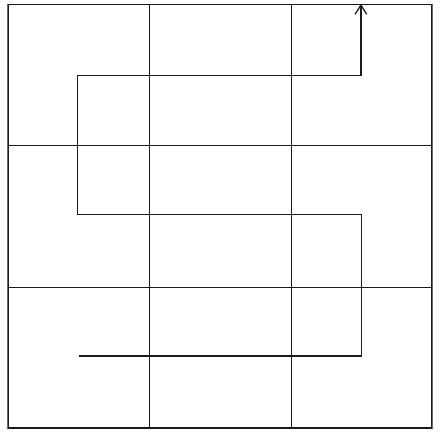
Figure 3: Filling curve path